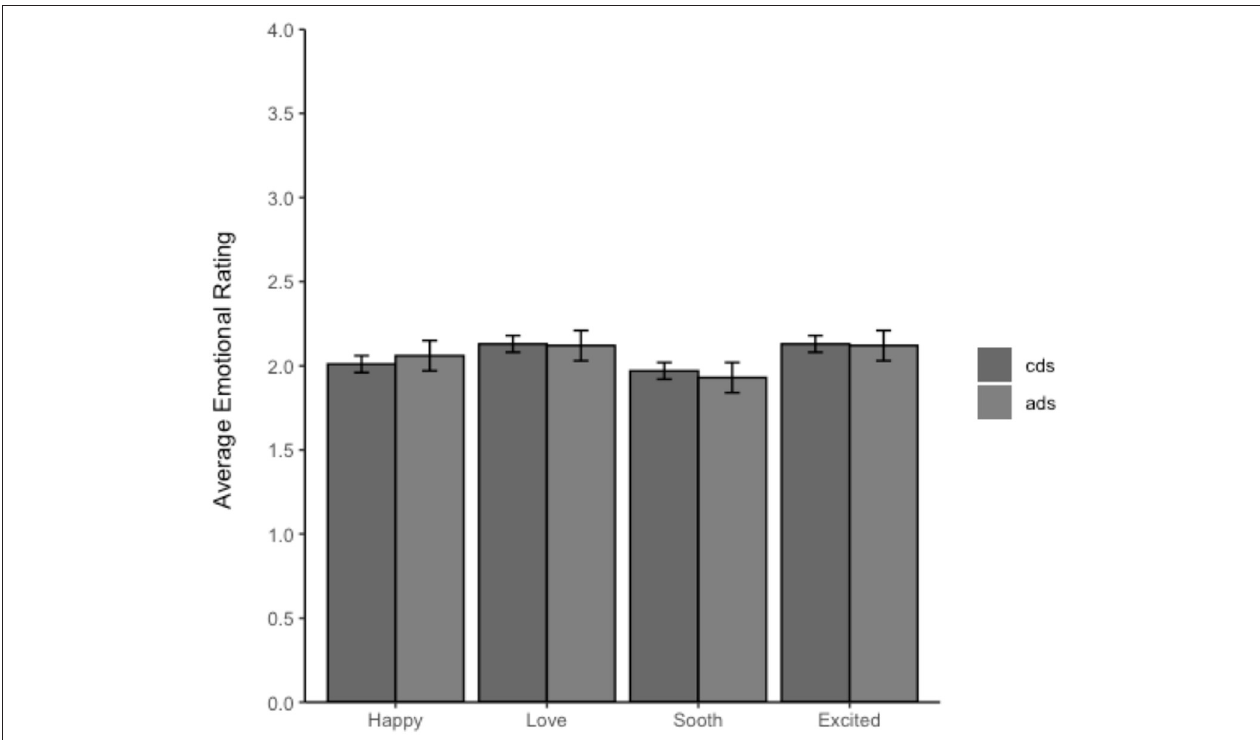
FIGURE 3 | Average ratings of the positive affect measures by addressee from Experiment 2b. The error bars represent the 95% CIs. The ratings on this scale were from 1 to 5 with 1 being neutral and 5 being “ sounded extremely ” like that emotion.